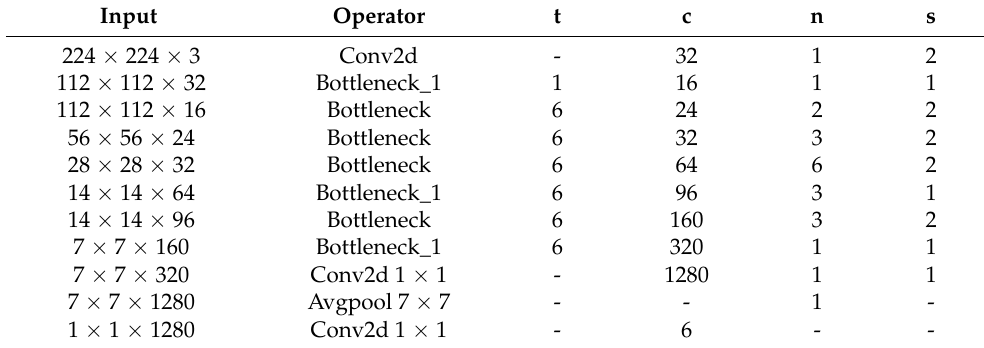
Table 2. The layer structure of the E-Mobilenetv2.